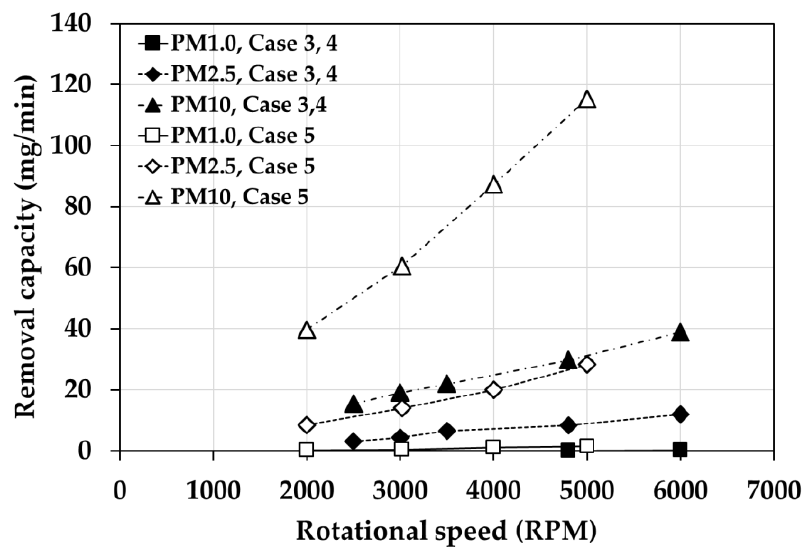
Figure 9. Oil-mist-removal capacity according to the rpm of the separator. A graph of the cyclone efficiency versus the particle size is sometimes S-shaped; the